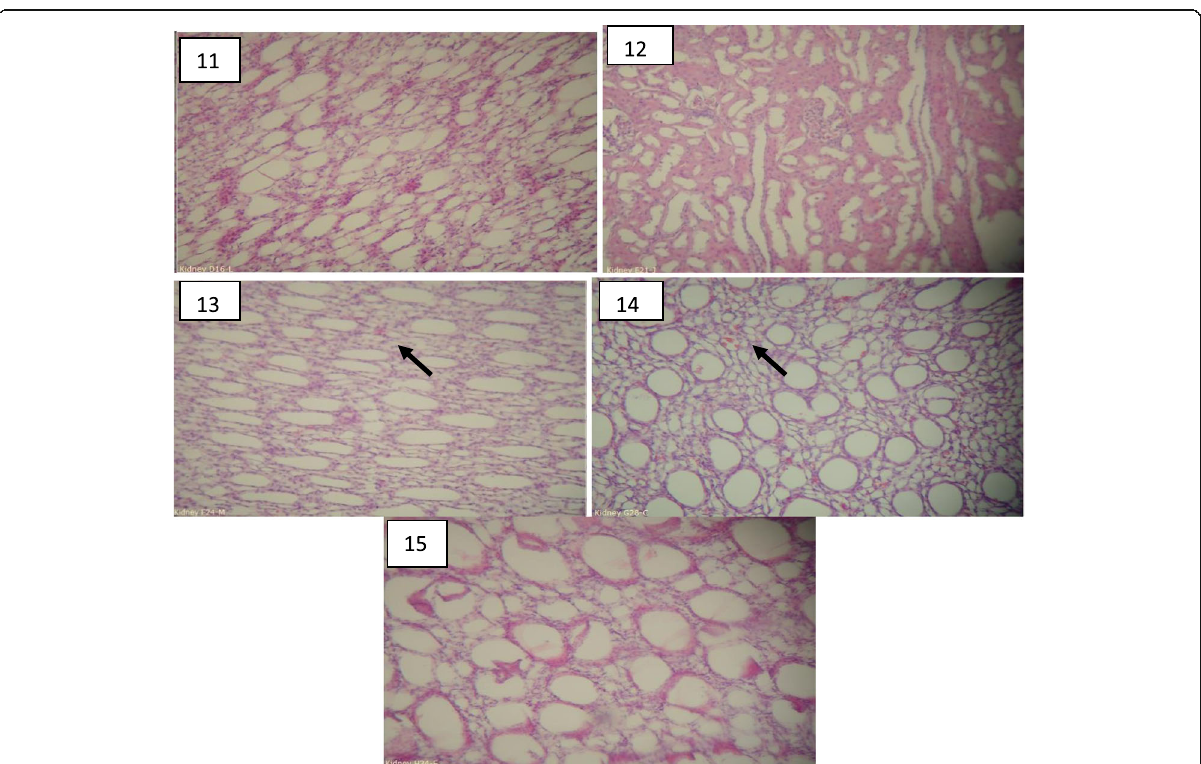
Fig. 3 Histological Sections of the Kidney. Plate 11 : Group (1): given continuous salt load. The glomeruli appear to have marked lymphocytosis with hyperchromatic nucleus. Plate 12 : Group (2): given salt load and aqueous extract. The glomeruli appear to have marked lymphocytosis with hyperchromatic nucleus and congested blood vesicles. Plate 13 : Group (3): given salt load and ethanolic extract. The glomeruli appear to have marked lymphocytosis with hyperchromatic nucleus. There is also haemorrhage as indicated with an arrow. Plate 14 : Group (4): given salt load and distilled water. The glomeruli appear to have mild lymphocytosis. There is also haemorrhage as indicated with an arrow. Plate 15 : Control group (5): given distilled water. Shows normal glomerular of the